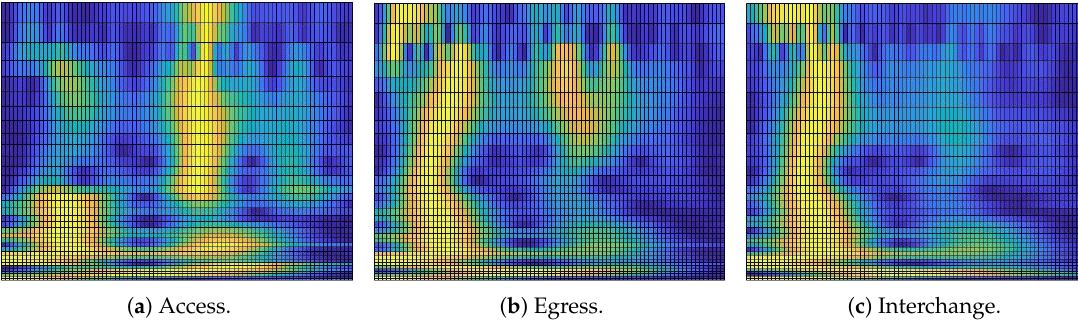
Figure 4. Plain text AEI